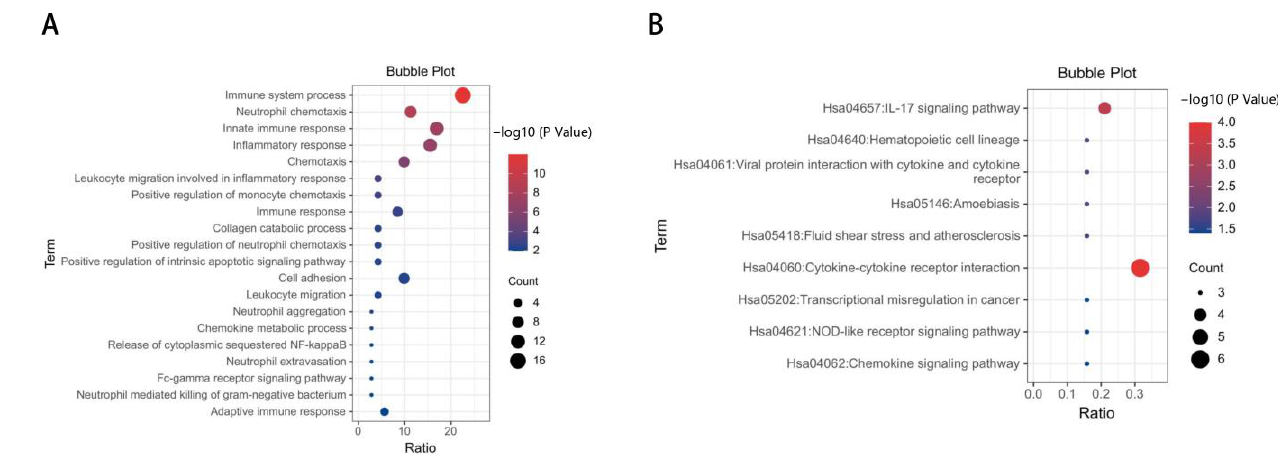
Figure 2. GO and KEGG enrichment analysis of DEGs. ( A ) Advanced bubble chart shows GO en- enrichment significance items of DEGs in biological processes. The x -axis label represents the gene richment significance items of DEGs in biological processes. The x-axis label represents the gene ratio, and the y -axis label represents GO terms. ( B ) KEGG enrichment result of DEGs. The x -axis ratio, and the y-axis label represents GO terms. ( B ) KEGG enrichment result of DEGs. The x-axis represents gene ratio and y -axis represents KEGG terms. The size of circle represents gene count. represents gene ratio and y-axis represents KEGG terms. The size of circle represents gene count. Different color of circles represents different adjusted p value. Different color of circles represents different adjusted p